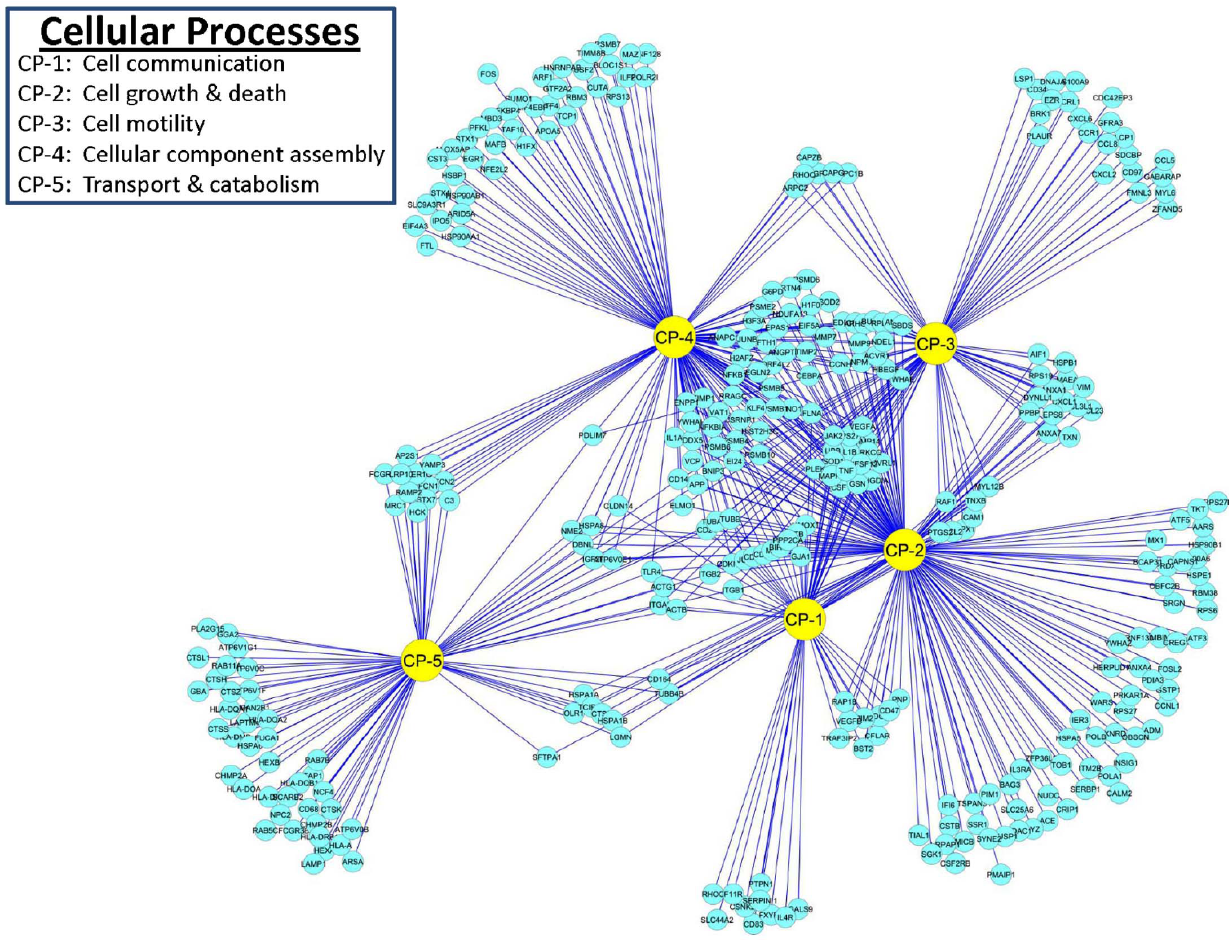
Figure 6. DE gene distributions and interactions among functional categories associated with Cellular Processes in PAMs infected with PRRSV.